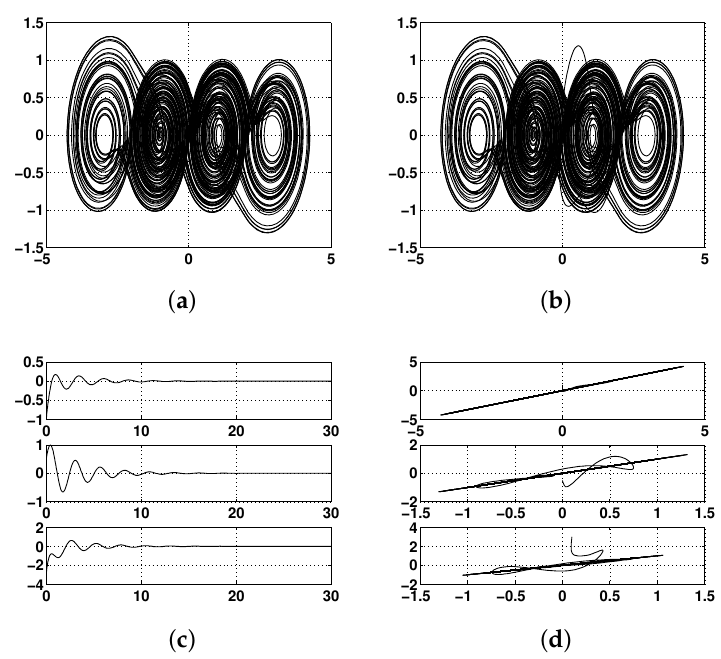
Figure 16. Master–slave synchronization of two four-scroll chaotic attractors with a = b = c = d 1 = 0.7: ( a ) master oscillator; ( b ) slave oscillator; ( c ) error synchronization; and ( d ) error phase diagram for the states of the master x and the slave ξ .